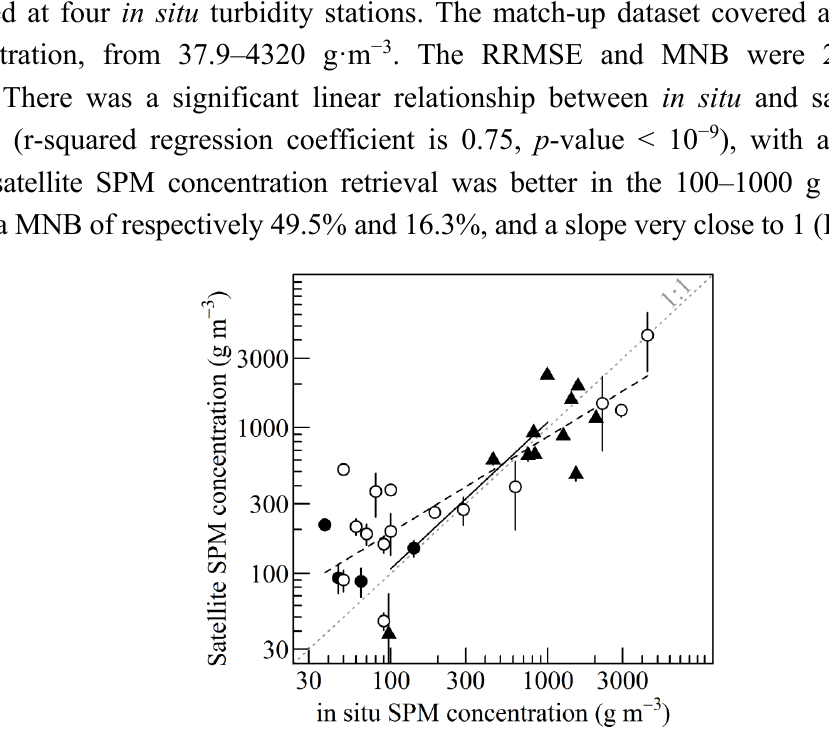
Figure 4. Suspended particulate matter (SPM) concentration match-up between in situ measurements and satellite data, respectively obtained using SPOT4 (black circles) and Landsat (black triangles) in the Gironde estuary, and SPOT4 (white circles) in the Loire estuary. Vertical lines show the standard deviation of the four pixels selected for match-up. The dashed line shows the linear fit from 37.9–4320 g·m − 3 , whereas the solid line shows the linear fit between 100 and 1000 g·m − 3